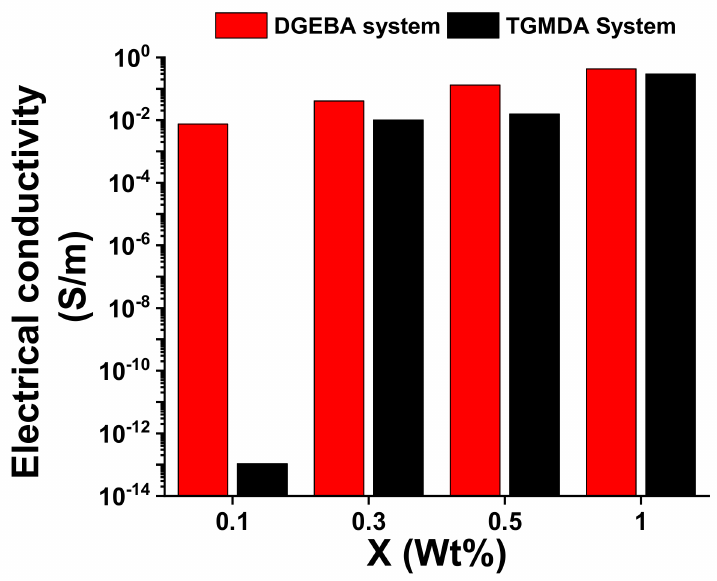
Figure 5. Comparison of the bulk conductivity for the two different polymeric resins reinforced with different concentrations of